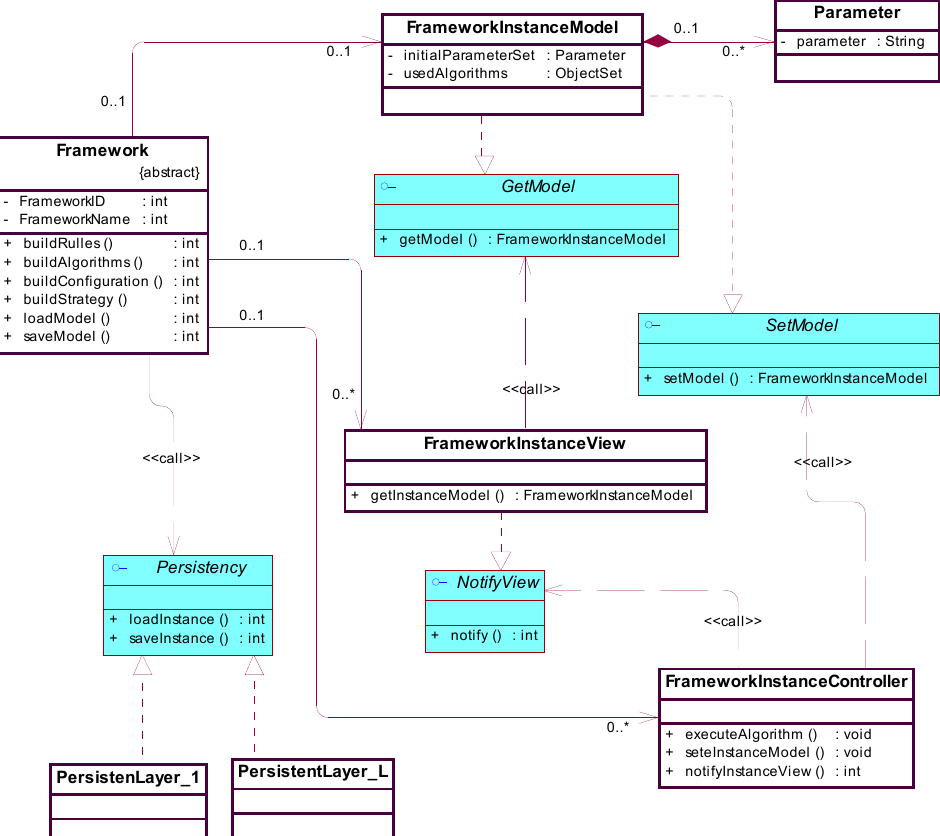
Figure 3. The initial framework conceptual model—persistency aspect.